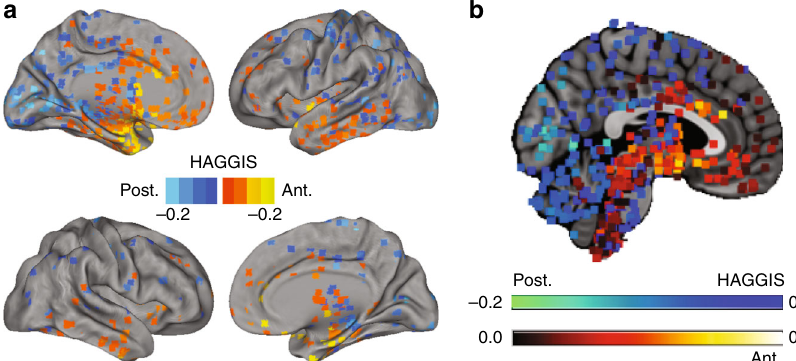
Fig. 4 Spatial distribution of the HAGGIS across the brain. a Each sample was projected onto a cortical surface based on its MNI coordinates. Warm colors indicate the sample has a gene expression pattern more similar to the anterior hippocampus (higher HAGGIS), while cool colors represent the sample is more genomically similar to the posterior hippocampus (lower HAGGIS). b A medial slice inclusive of brainstem and cerebellum. Each dot represents a sample, and warm colors indicate higher HAGGIS, while cool colors represent lower HAGGIS. HAGGIS Hippocampal Axis Genomic